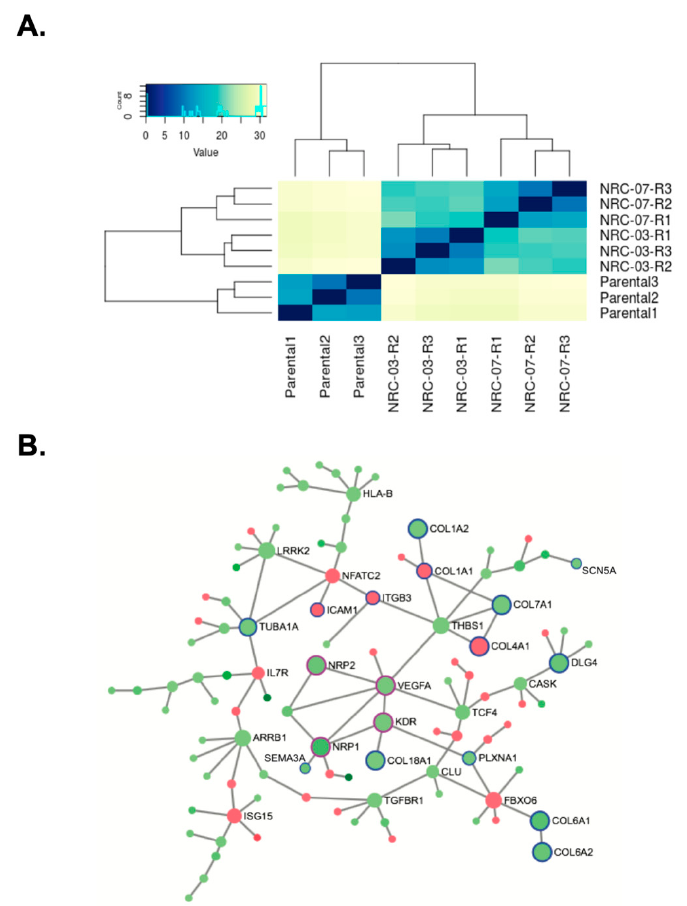
Figure 6. Breast cancer cell resistance to NRC-03 and NRC-07 is associated with the di ff erential expression of genes involved in angiogenesis and ECM interaction-related pathways. ( A ) RNA sequencing analysis was performed on parental MDA-MB-231 cells, NRC-03-resistant MDA-MB-231 cells, and NRC-07-resistant MDA-MB-231 cells. The heat map compares the three cell lines. The color key and histogram are in the upper left quadrant. R1, R2 and R3 refer to distinct biological replicates. ( B ) A zero-order interaction network of di ff erentially expressed genes between parental cells and peptide-resistant cells was prepared using NetworkAnalyst [17]. Up-regulated and down-regulated genes are shown as red and green filled circles, respectively. Up-regulated and down-regulated genes involved in angiogenesis, antigen processing and presenting, and ECM interactions are outlined in purple and blue,